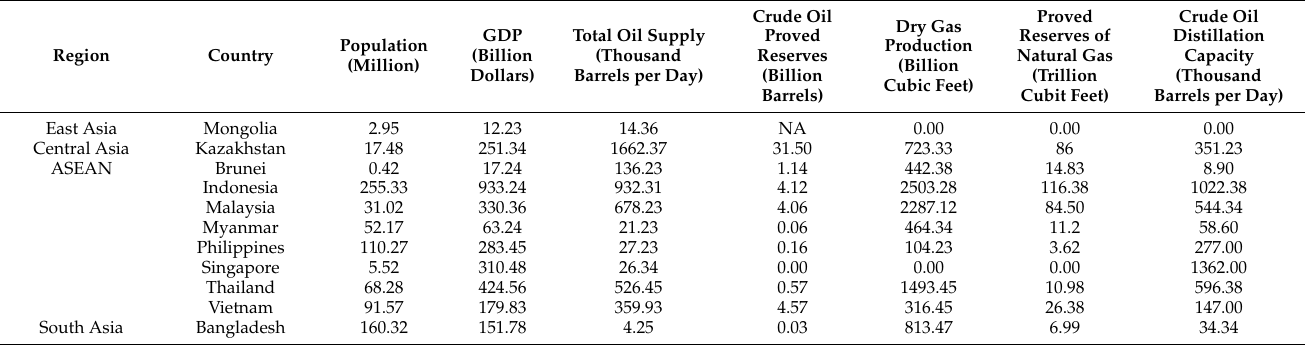
Table A3. Main statistics of 50 Nations alongside the China’s “Belt & Road Initiative in 2015”.